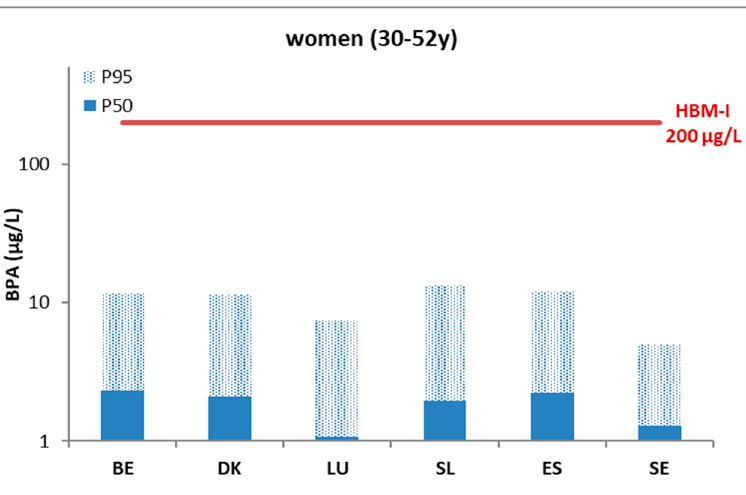
Figure 1. Urinary levels (µg/L) of bisphenol A (BPA)-equivalents in mothers (50th and 95th percentile) in six EU countries (DEMOCOPHES) benchmarked against the German HBM-I guidance value below which no adverse health effects are expected according to current knowledge. BE: Belgium; DK: Denmark; LU: Luxembourg; SL: Slovenia; ES: Spain; SE: Sweden.